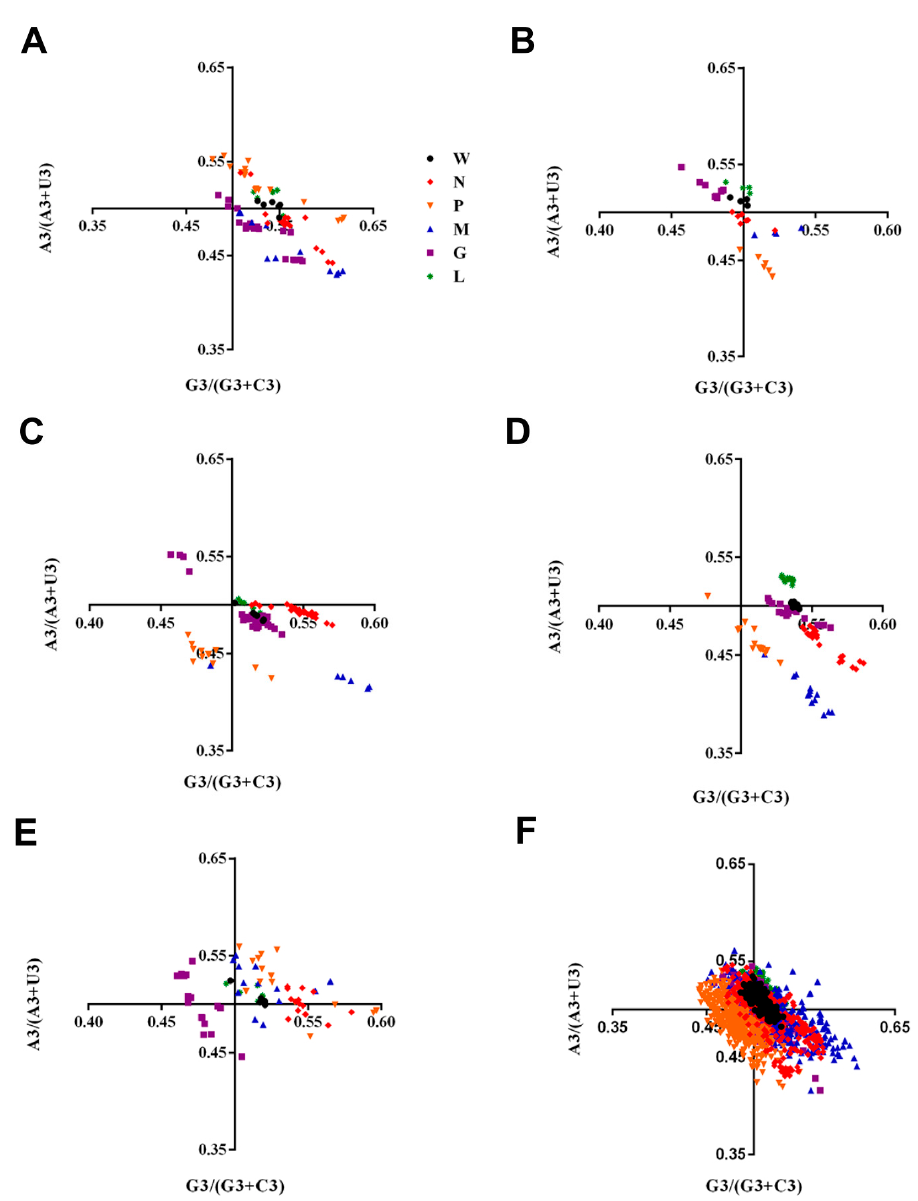
Figure 4. PR2 plot analysis. ( A ) LBV; ( B ) DUVV; ( C ) ABLV; ( D ) EBLV-1; ( E ) MOKV; ( F ) RABV. W means whole genome. Black, red, orange, blue, purple and green represent whole genome, N gene, P gene, M gene, G gene and L gene, respectively.